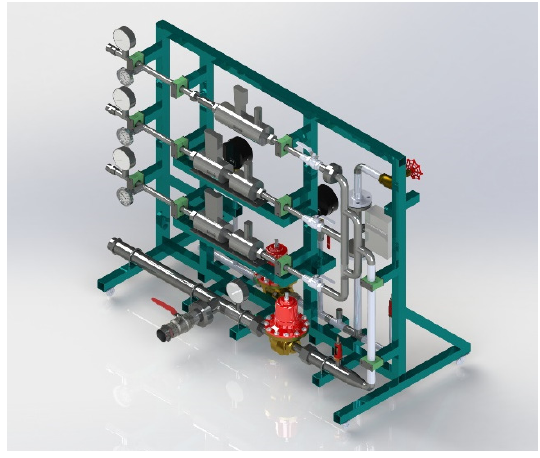
Figure 2. Model of a mixing station.